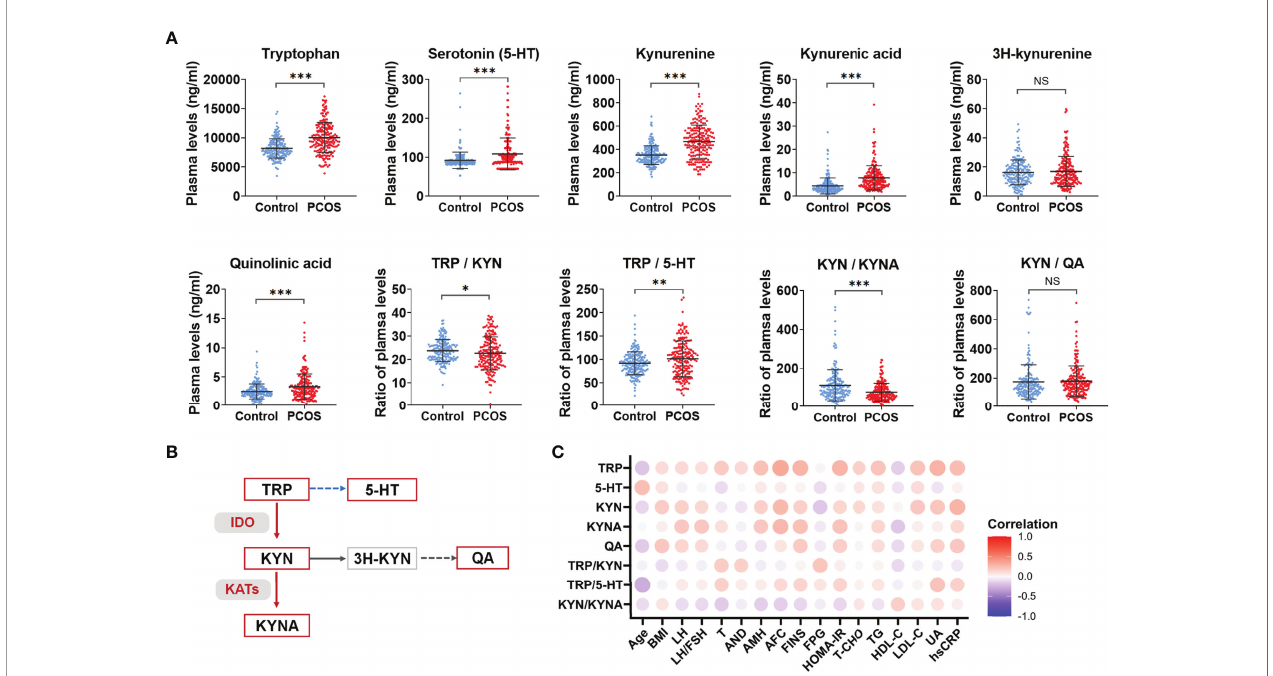
FIGURE 1 | Abnormal activation of tryptophan-kynurenine pathway in PCOS. (A) The plasma level changes of metabolites in tryptophan-kynurenine pathway in PCOS patients compared with control groups, *** p < 0.001; ** p < 0.01; * p < 0.05; NS, not signi fi cant. (B) The sketch Map of changes of metabolites and key enzymes in tryptophan-kynurenine pathway in PCOS patients. The red color indicates increased metabolism and activated enzymes, the blue color indicates decreased metabolism, and the grey color indicates that the change trend of this pathway was not yet clear. (C) Correlation analysis of differential metabolites levels with the endocrine and metabolic parameters in all subjects. TRP, tryptophan; 5-HT, serotonin; KYN, kynurenine; KYNA, kynurenic acid; QA, quinolinic